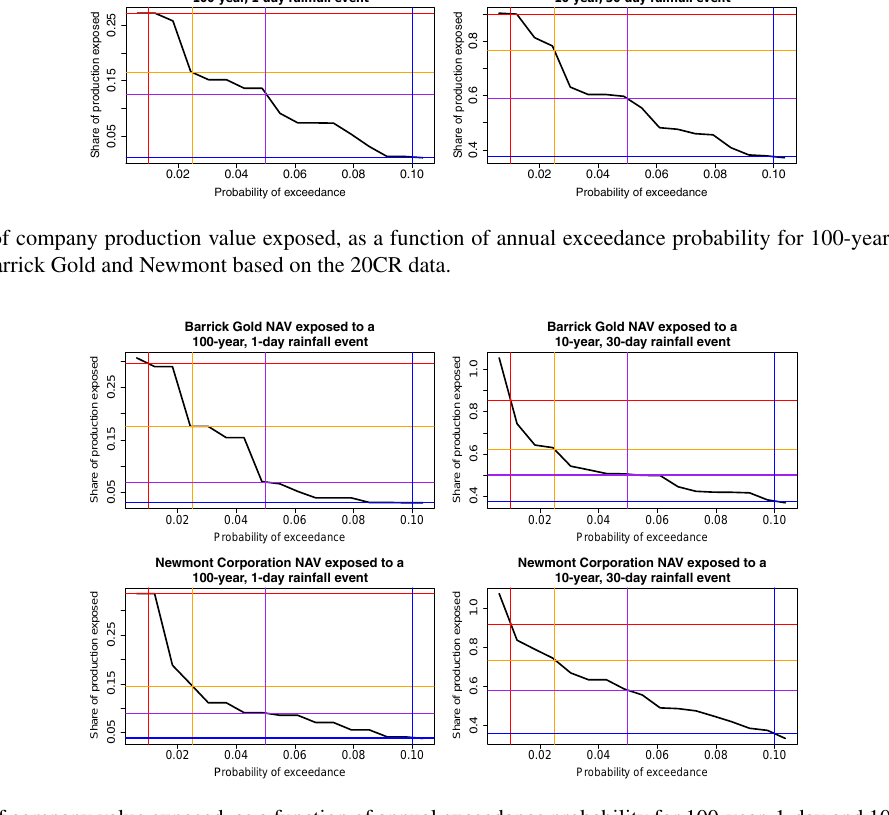
Figure 8. Fraction of company value exposed, as a function of annual exceedance probability for 100-year, 1-day and 10-year, 30-day events for Barrick Gold and Newmont based on the 20CR